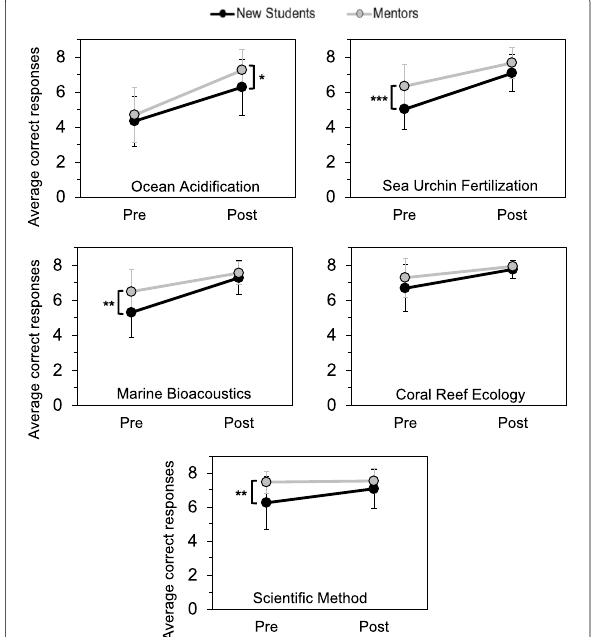
Fig. 7 Performance: Comparing iClicker scores between student groups. Differences between student groups compared with paired Student’s t -tests. * p < 0.05. ** p < 0.01. *** p < 0.001